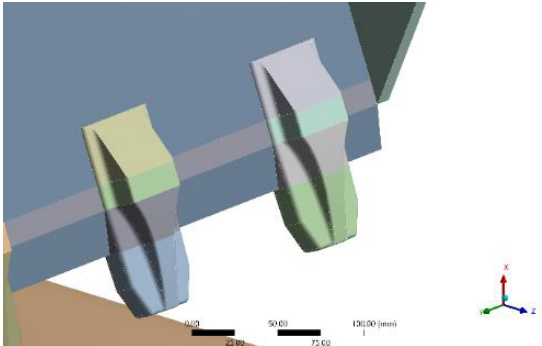
Figure 8. Model of the excavator bucket teeth.